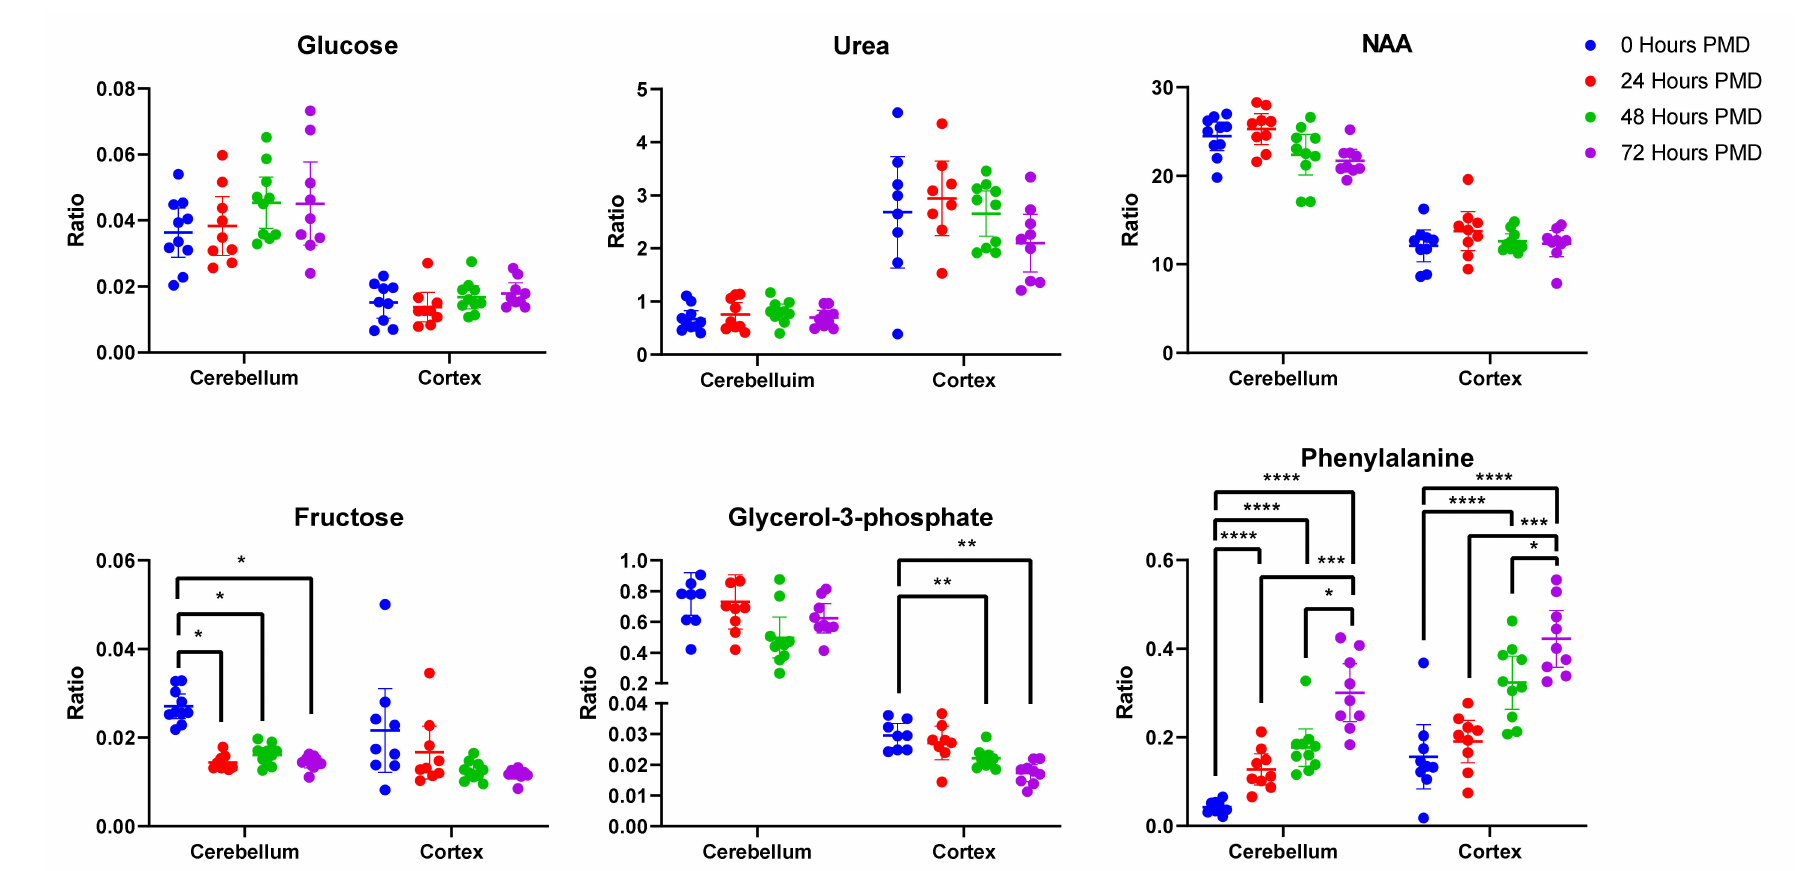
Figure 2. Unaltered and Altered Metabolites in Rat Brain Tissue. Data shown is individual metabolite ratios ± 95% confidence intervals. 23 identified unique metabolites were unchanged in either the rat cortex or cerebellum over a period of 72 h post-mortem delay (PMD), including metabolites previously associated with AD such as glucose, urea, and n-acetylaspartic acid. In the cortex, 22 metabolites were altered by 72 h PMD including glycerol-3-phosphate and phenylalanine. 23 metabolites were altered in the cerebellum by 72 h PMD, including fructose and phenylalanine. * < 0.05, ** < 0.01, *** < 0.001, **** < 0.0001. PMD = post-mortem delay. Individual sample values, mean ratios, and fold-changes for all metabolites in the cortex and cerebellum can be found in Supplementary Materials